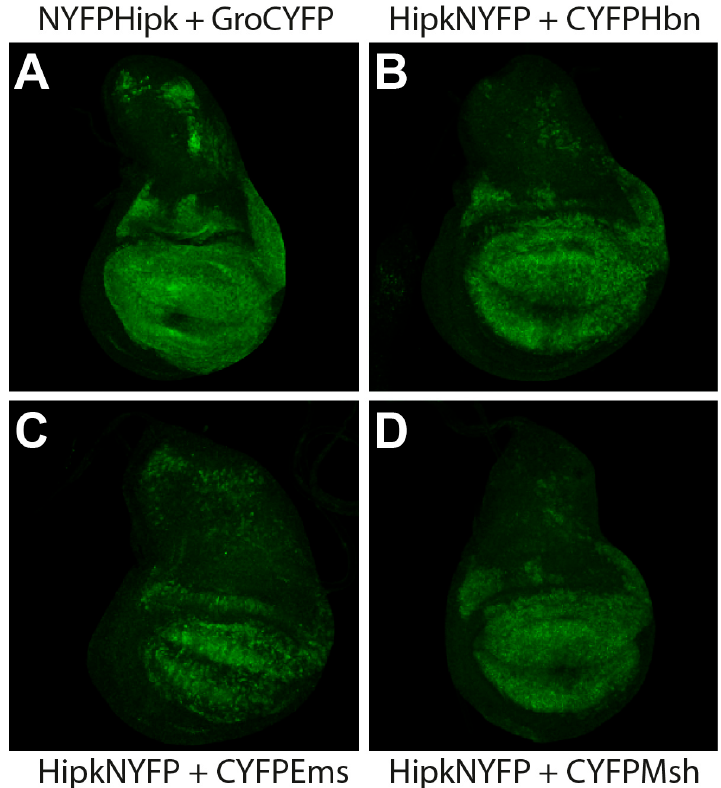
Figure 1. Visualization of physical interaction of Hipk with Ems, Msh, and Hbn, respectively, in vivo through bimolecular fluorescence complementation (BiFC) in Drosophila third larval instar wing imaginal discs. Anterior is to the left. MS1096-Gal4 was used to ectopically express UAS-BiFC-constructs. All discs were stained with anti-GFP antibody (green) to enhance the BiFC signal. ( A ) Groucho (Gro), as a confirmed substrate of Hipk, served as positive control. Co-Expression of UASNYFP hipk and UAS gro CYFP leads to physical interaction of both proteins (NYFPHipk + GroCYFP) and therefore reconstitution of YFP. ( B ) Co-expression of UAS hipk NYFP and UASCYFP hbn leads to reconstitution of YFP (HipkNYFP + CYFPHbn). ( C ) Co-Expression of UAS hipk NYFP and UASCYFP ems allows physical interaction of both proteins (HipkNYFP and CYFPEms) and therefore reconstitution of YFP. ( D ) Co-expression of UAS hipk NYFP and UASCYFP msh leads to reconstitution of YFP (HipkNYFP + CYFPMsh). For controls and for MS1096 > UAS-enhanced GFP displaying expression pattern of MS1096 driver, see Figure S1.